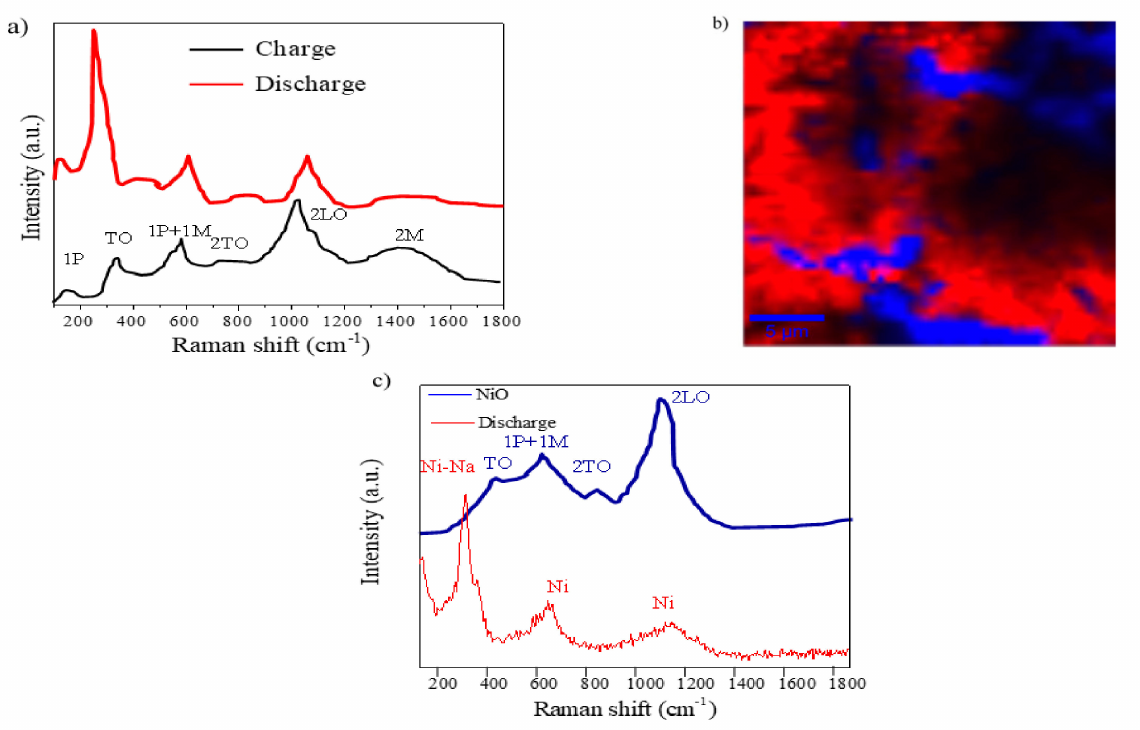
Figure 8. A confocal micro-Raman analysis: ( a ) the Raman spectra of NiO-0V and NiO-3V films; ( b ) the Raman image of a discharged NiO film (integration time of 0.03 s); the colors in the spectra correspond to different areas in the Raman image using a filter for 278 cm − 1 ; and ( c ) the main Raman spectra associated with the two different